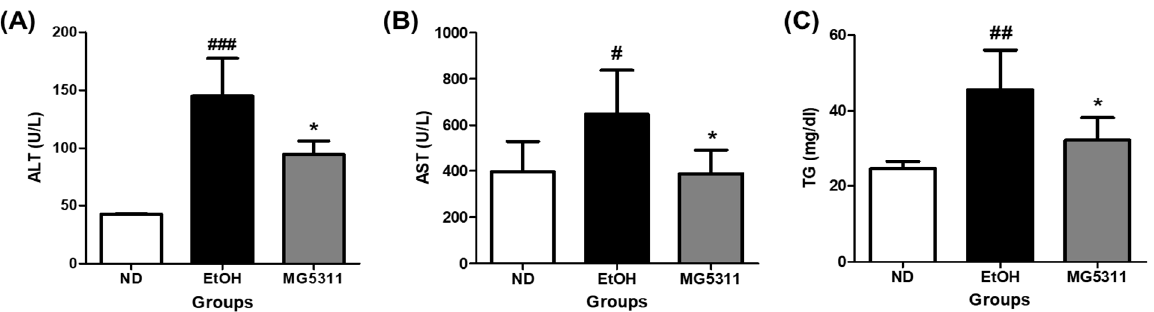
Figure 2. Effect of L. brevis MG5311 on hepatic markers in the serum of ethanol-fed mice. ( A ) alanine transferase (ALT); ( B ) alanine aminotransferase (AST); and ( C ) triglyceride (TG). Data are presented as mean ± SD ( n = 6). Significance was analyzed by Dunnett’s test. # p < 0.05, ## p < 0.01, ### p < 0.001 vs. ND group. * p < 0.05 vs. EtOH group. ND; normal diet, EtOH; ethanol diet, MG5311; ethanol diet- L. brevis MG5311.